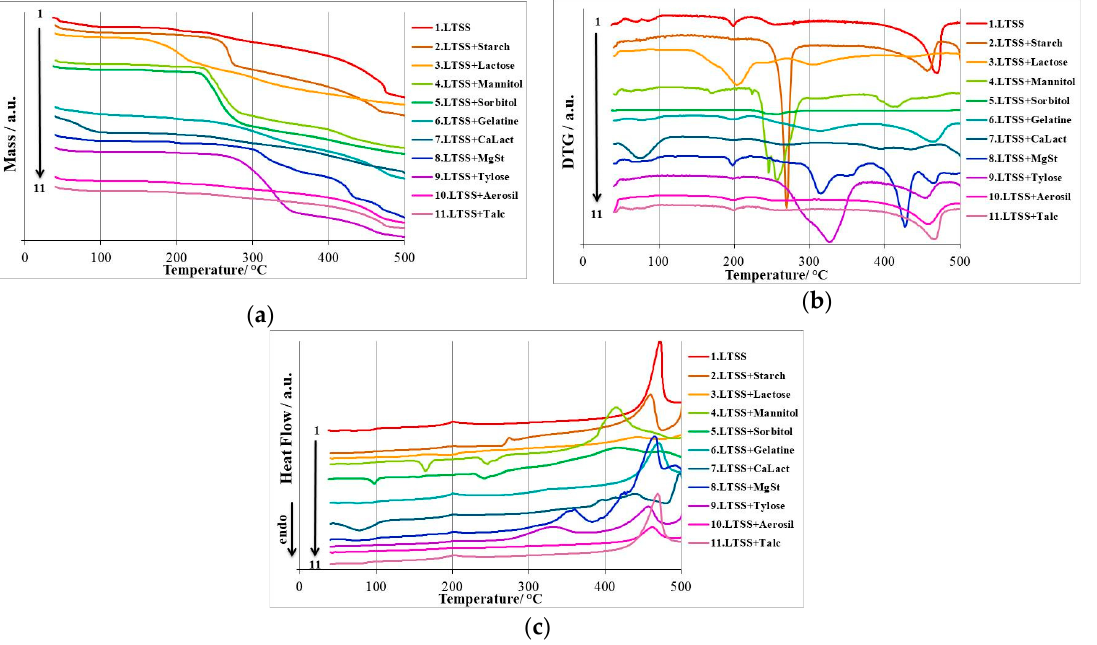
Figure 4. Superimposed thermoanalytical curves registered for LTSS and binary mixtures with excipients: ( a ) Mass vs. temperature curves (TG curves); ( b ) Mass derivative vs. temperature curves (DTG curves); ( c ) Heat flow vs. temperature curves (HF curves).